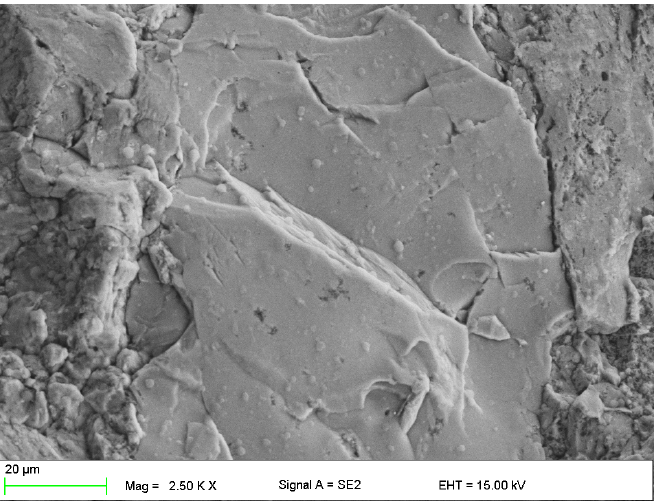
Figure 5 . The SEM image with the region marked as “III” in the Figure 4 obtained for the sintered Mg 63 Zn 30 Ca 4 Au 3 alloy. The image features the transcrystalline fracture.